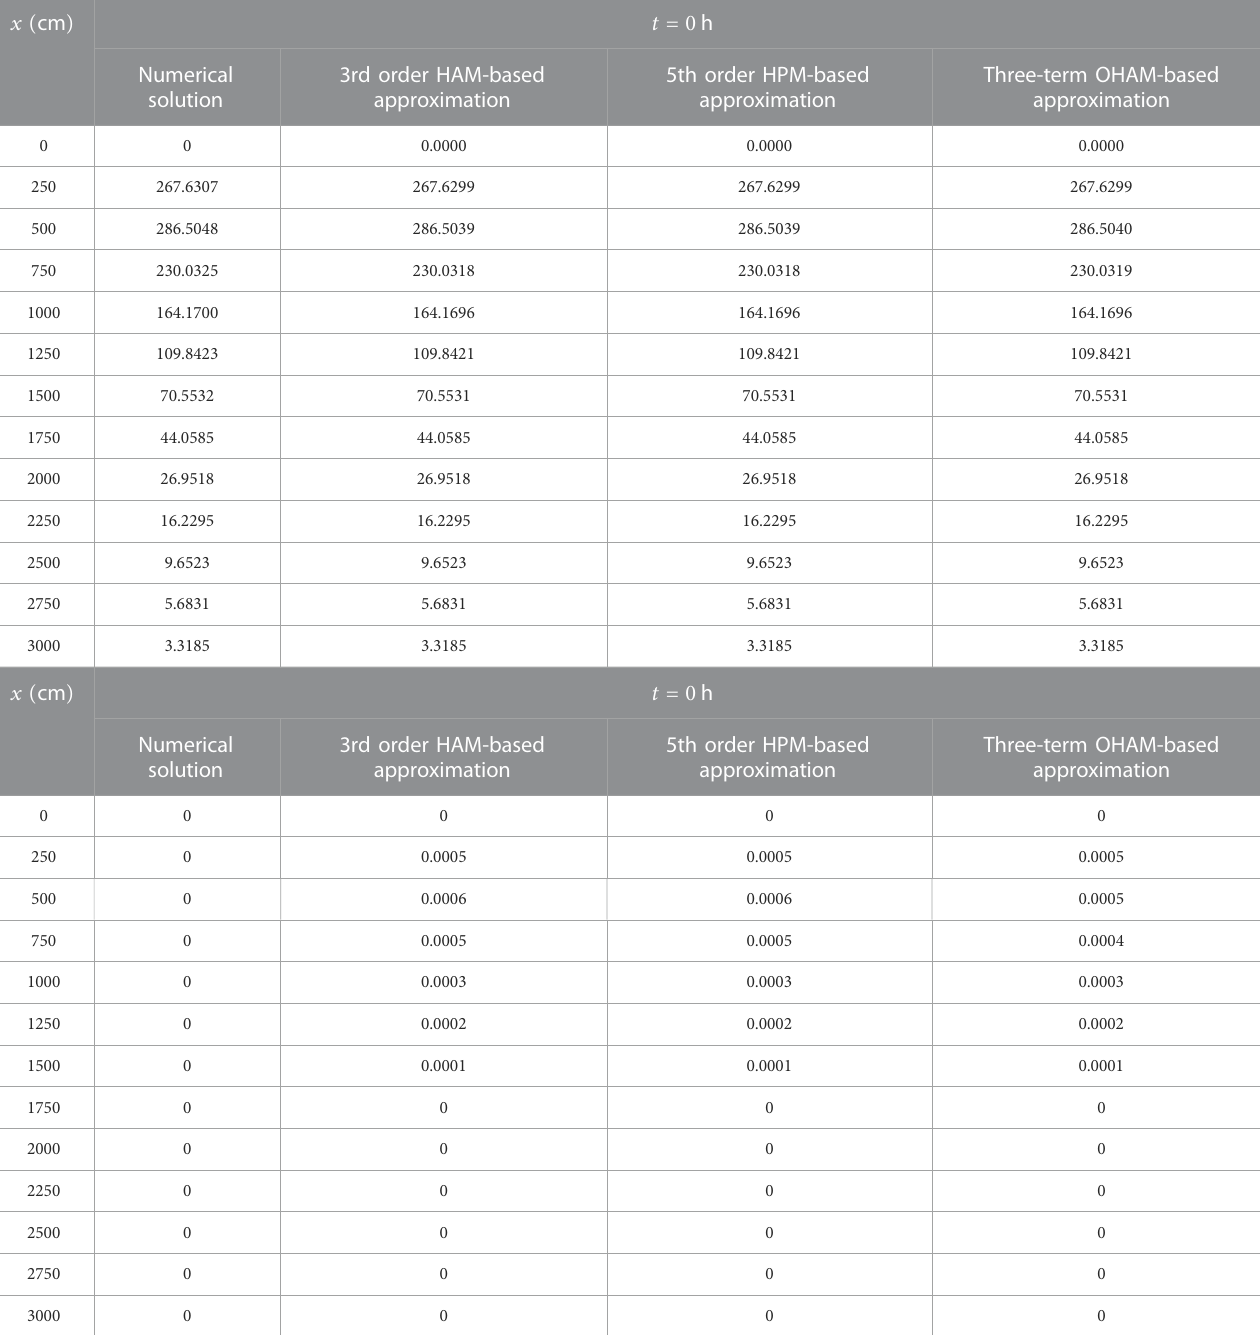
TABLE 1 Comparison between HAM-, HPM-, and OHAM-based approximations and numerical solution for the selected case for t (cid:2) 0 h: (a) C ( x,t ) (b) Species, C ( x,t Species, C 1 2